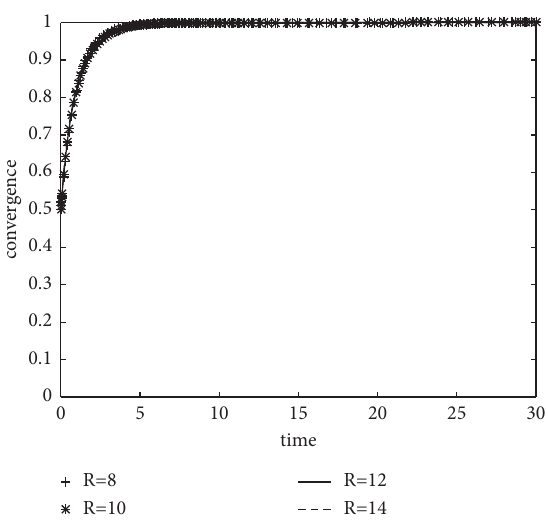
Figure 10: Impact of change R on